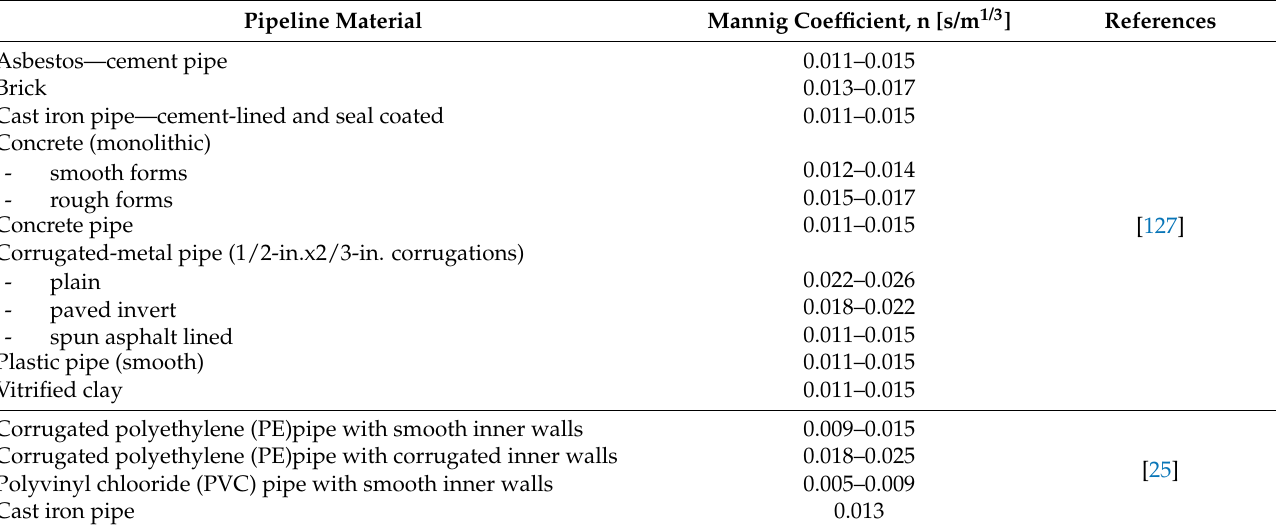
Table 2. Exemplary values of Manning’s roughness coefficient for the most popular sewerage pipeline